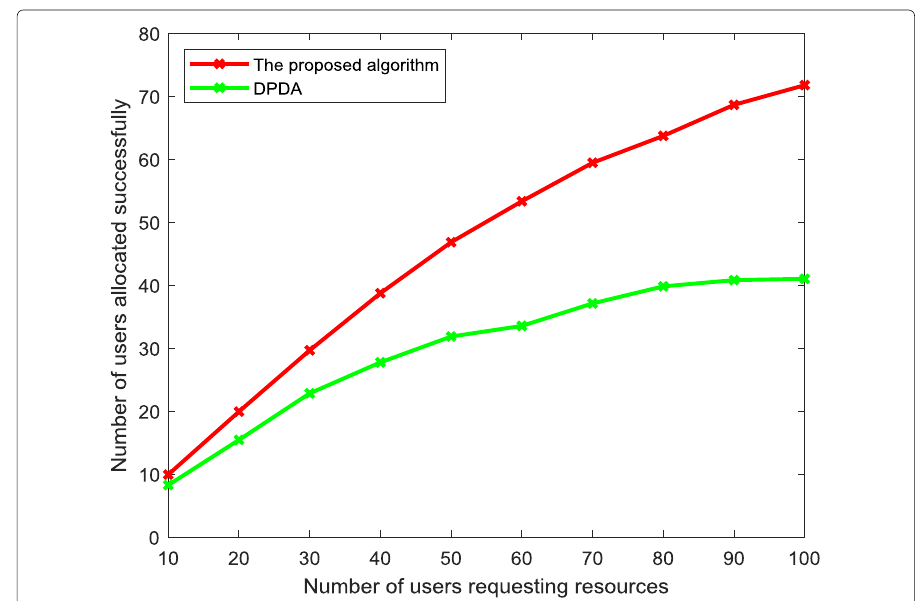
Fig. 8 The number of intelligent terminals successfully allocated in one auction